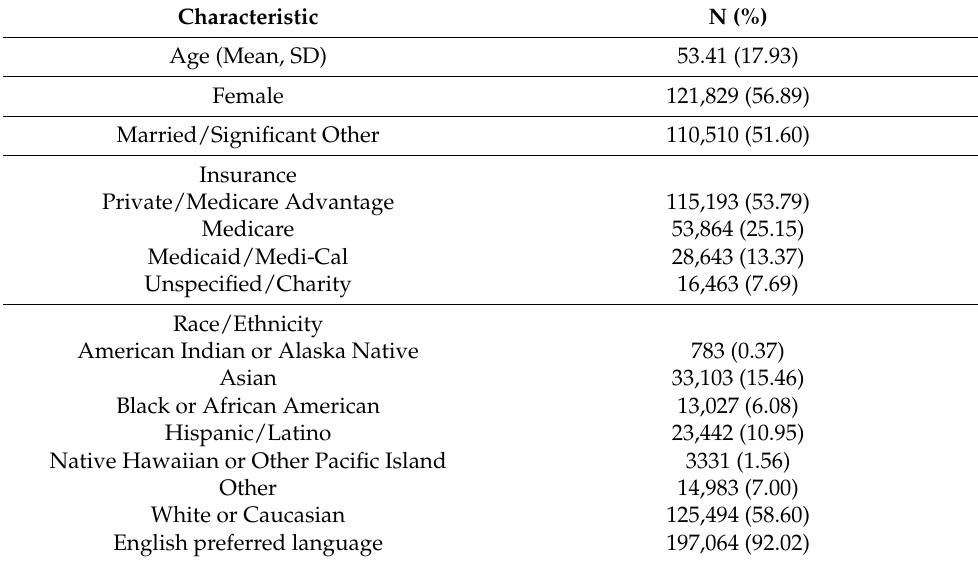
Table 1. Sociodemographic characteristics of the sample (N =